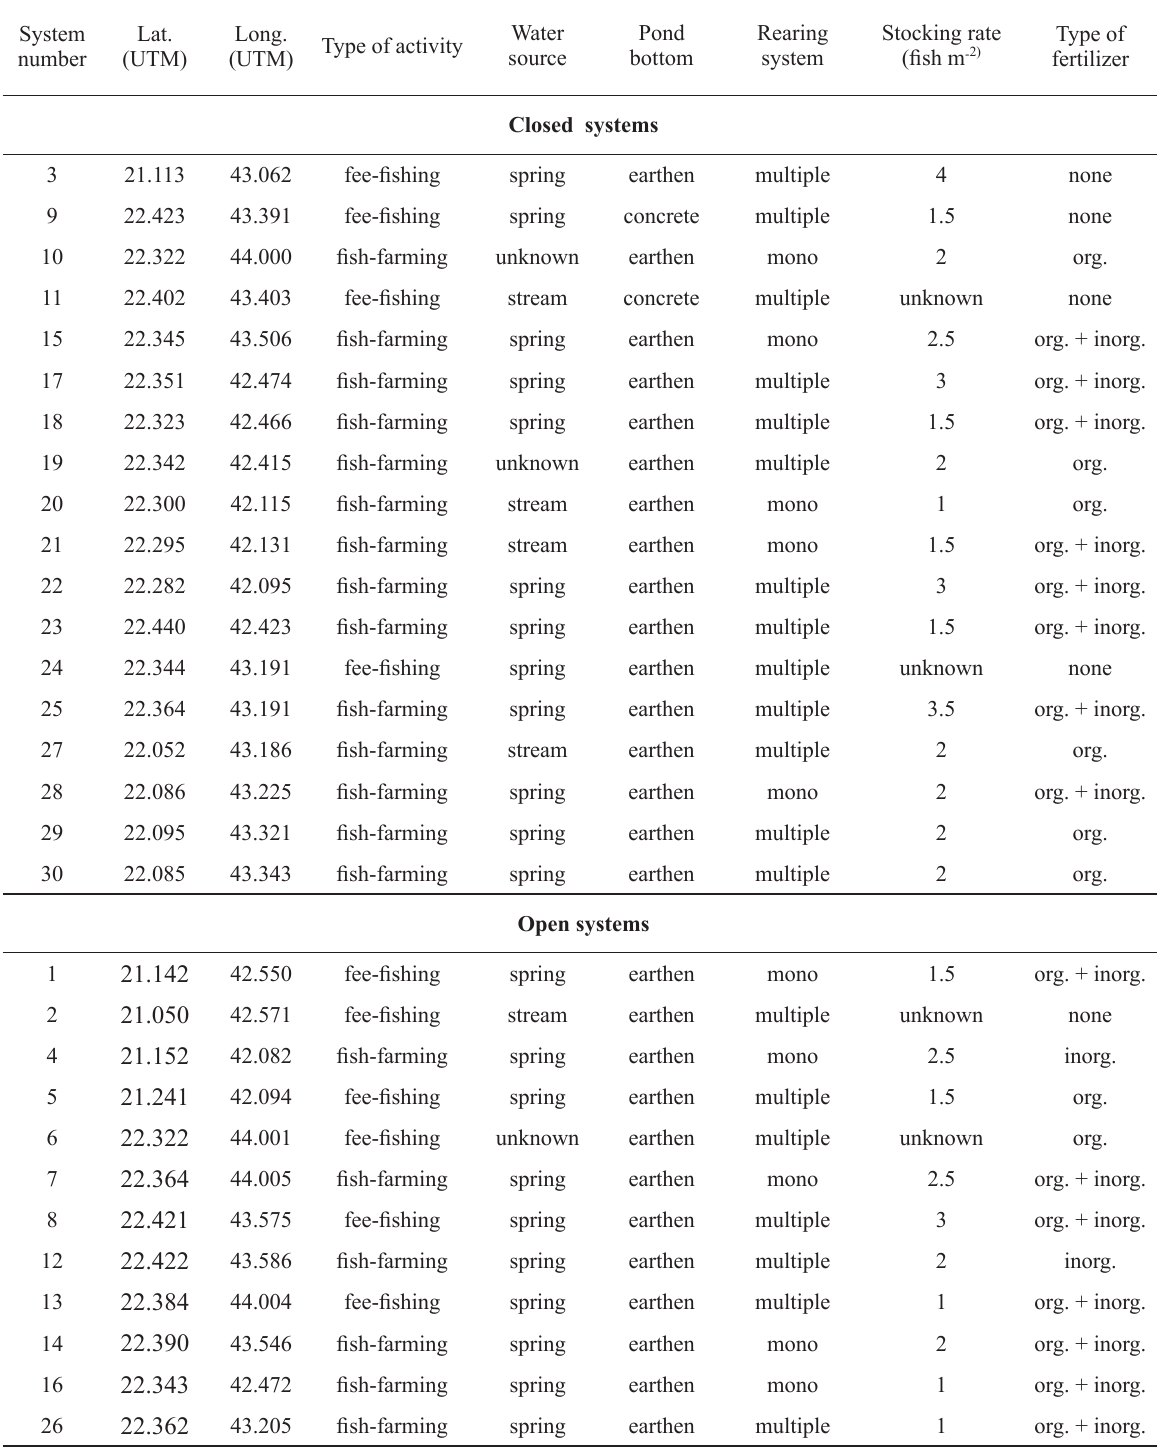
Main features of the aquaculture systems. org . = organic, inorg. = inorganic, multiple = multiple species, mono =